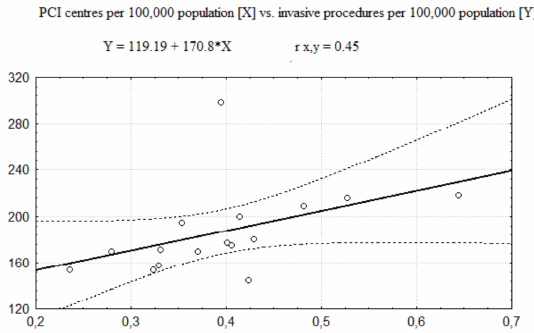
Figure 1. The regression function of PCI centres 100,000 population vs. number of invasive 100,000 population.